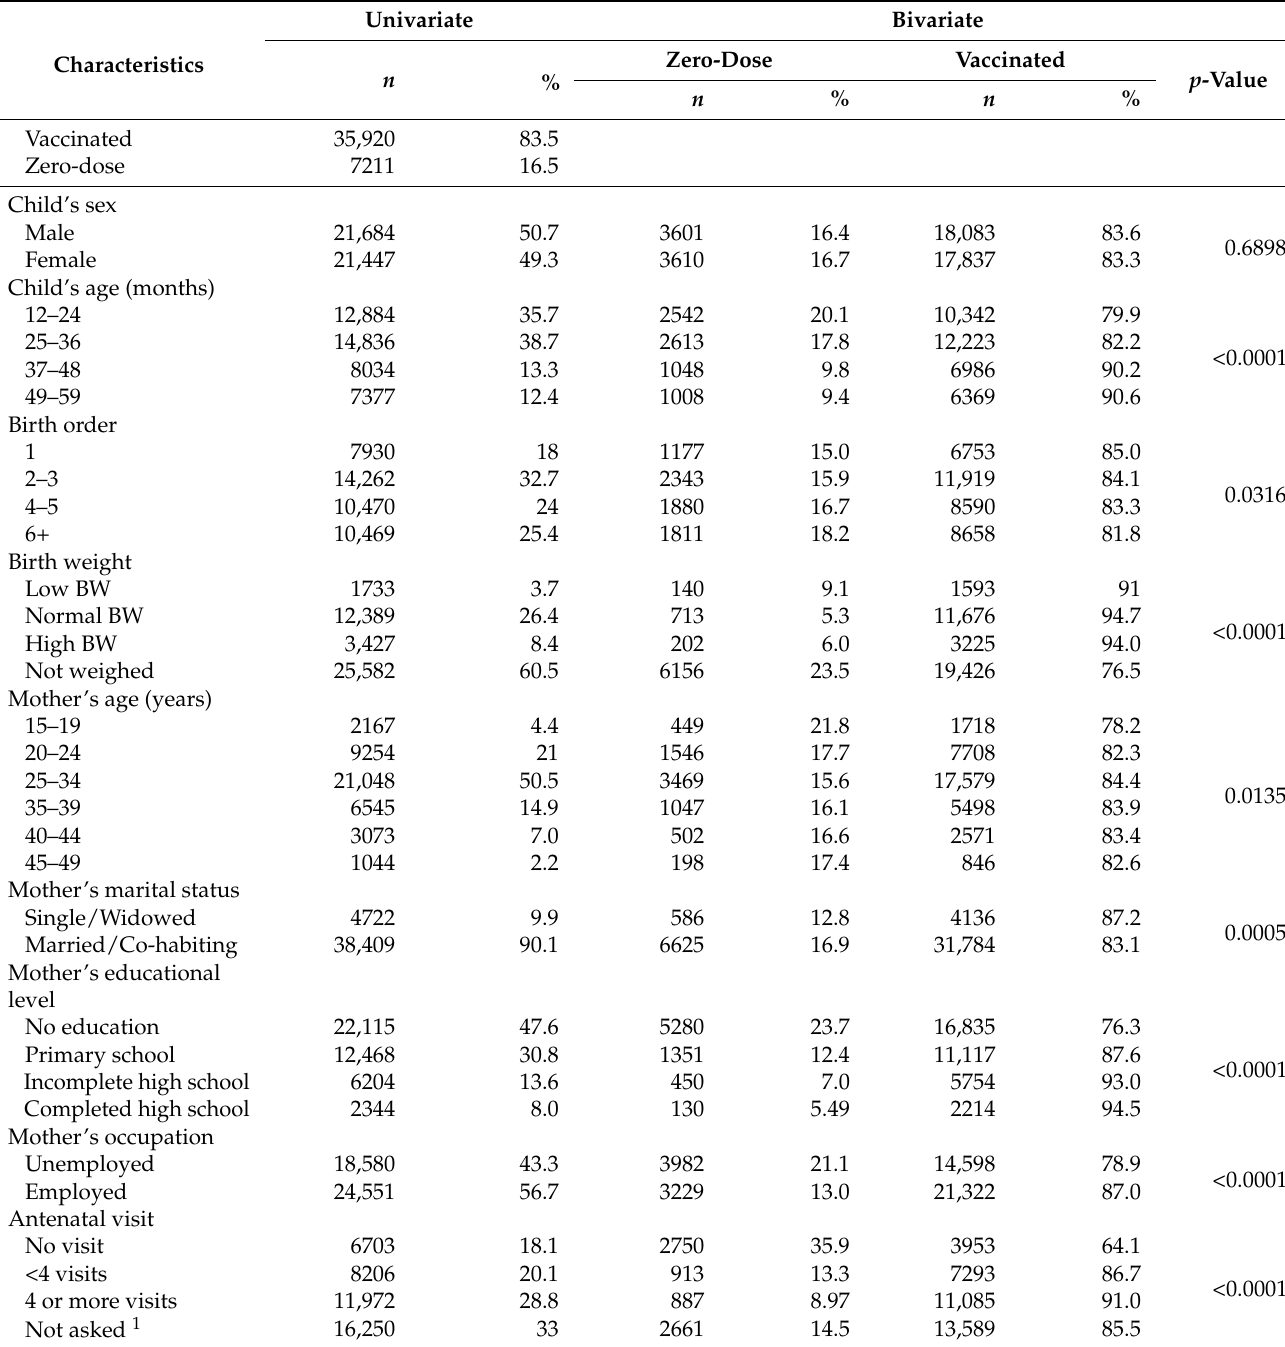
Table 2. Baseline characteristics and bivariate analysis of individual factors associated with zero-dose vaccination status among children aged 12–59 months in SSA ( N =